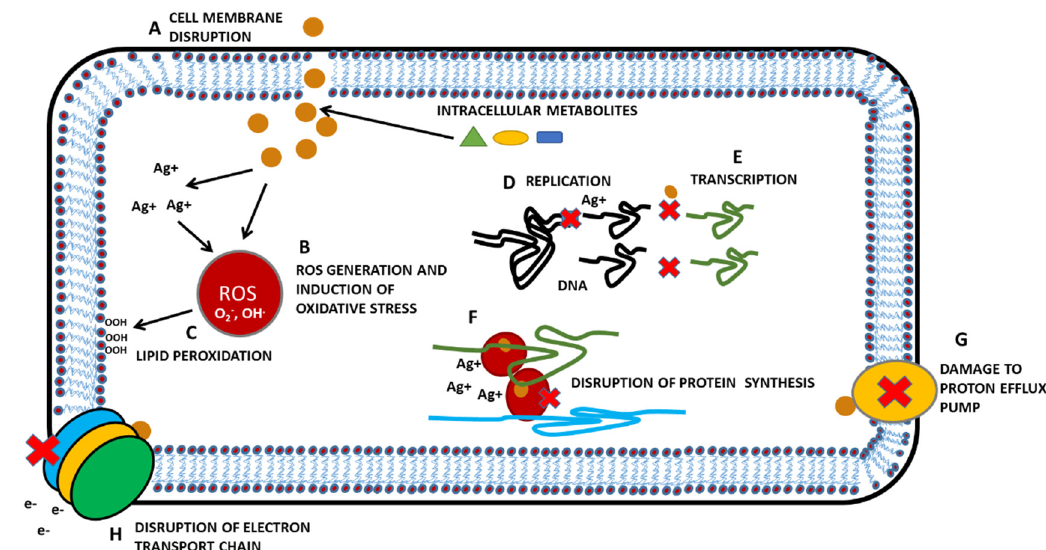
Figure 2. Effect of silver nanoparticles (AgNPs) on the single bacterial cell. ( A ) AgNPs penetrate through the cell membrane and cause its disruption; intracellular metabolites are released via the disrupted membrane. ( B ) AgNPs release silver ions (Ag + ) to generate reactive oxygen species (ROS) and induce oxidative stress. ( C ) ROS are, for example, responsible for lipid peroxidation, which significantly changes the distribution of intracellular and extracellular metabolites and causes a change in membrane permeability, because lipid strains are repulsed. Interaction of AgNPs and Ag + with proteins can affect ( D ) DNA enzymatic replication machinery, ( E ) DNA transcription, ( F ) translation of DNA to polypeptide/protein chain on ribosomes (red-brown ovals), ( G ) proton efflux pumps, ( H ) electron transport chain (represented by blue, yellow and green ovals) and creation of energetic sources of cells (ATP). Adapted from [31], Copyright Springer Nature, 2013.